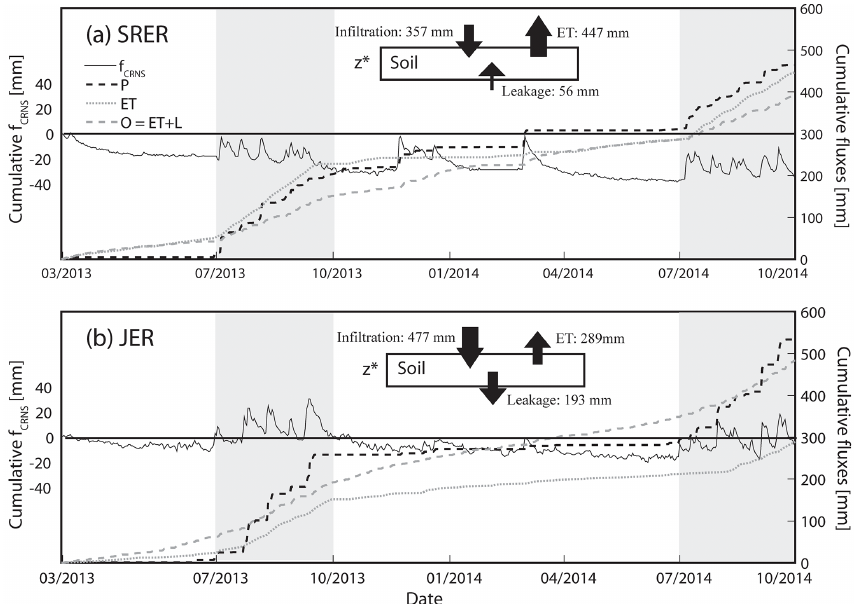
Figure 9. Comparison of cumulative f CRNS and measured water balance fluxes ( P and ET) during study period. CRNS estimates of infiltra- tion ( I ), outflow ( O) , and leakage ( L ) are either depicted as cumulative fluxes ( O = ET + L ) or as total amounts during the study period ( I and L ) as arrows in the soil water balance box of depth z ∗ . Shaded regions indicate the summer seasons (July–September). The horizontal line represents f CRNS = 0.